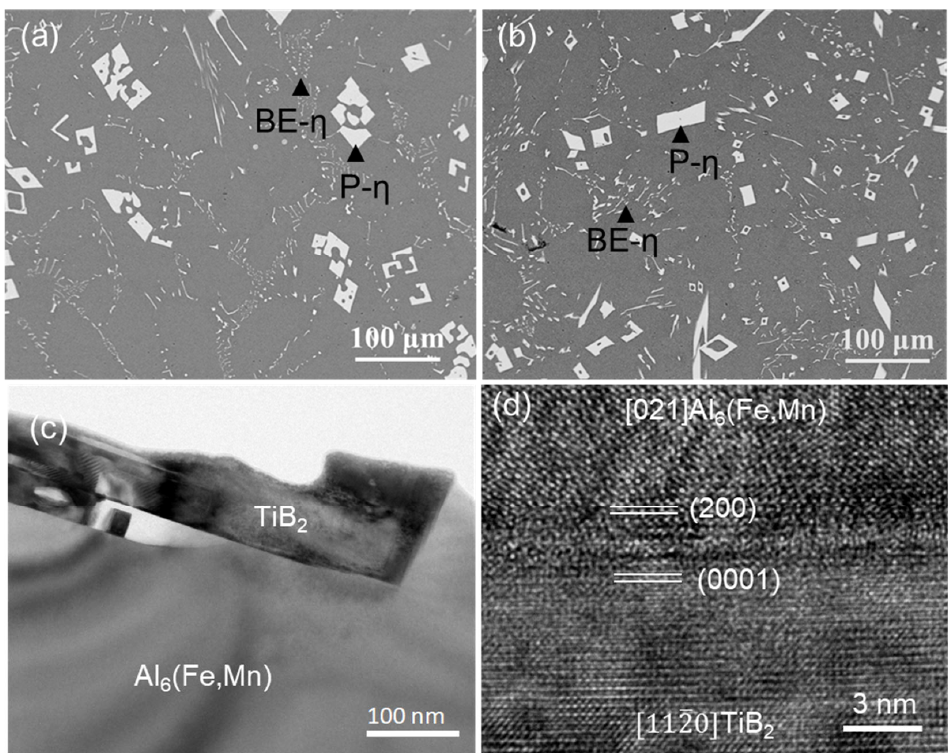
Figure 20. Mn ‐ modified TiB 2 particles nucleate η‐ Al 6 (Fe, Mn) phase and refine η‐ Al 6 (Fe, Mn) phase in Al ‐ 2Mn ‐ 1.0Fe alloy. SEM images showing the microstructure of Al ‐ 2Mn ‐ 1.0Fe alloy solidified at 3.5 K/s ( a ) without grain refiner addition, ( b ) with 1000 ppm novel grain refiner addition (Mn ‐ modified TiB 2 particles); ( c ) TEM bright ‐ field image showing the TiB 2 / η‐ Al 6 (Fe, Mn) interface, ( d ) high ‐ resolution TEM image showing the modified TiB 2 / η‐ Al 6 (Fe, Mn) interface. [82]. The grain refinement results are summarised in Table 5. The interfacial segregation of different elements, such as Fe, Mn, and Si, on AlB 2 or TiB 2 particles [82] were investi ‐ gated and confirmed on an aberration (Cs) ‐ corrected FEI Titan 80–200 instrument equipped with Super ‐ X energy ‐ dispersive X ‐ ray spectroscopy (Super ‐ X EDS) system. These different types of Al ‐ Ti ‐ B master alloys containing modified AlB 2 or TiB 2 particles were added to different alloys shown in Table 5 to test their effect on refining both FIMCs and α‐ Al. It shows that the TiB 2 particles with Fe and Si segregation (TiB 2 (Fe, Si)) are most effective. It can refine not only α and β FIMCs, but also the primary Si phase. TiB 2 (Fe, Si)) particles refined the α‐ Al 15 (Fe, Mn) 3 Si 2 from 38.7 ± 6.8 μ m to 11.1 ± 4.4 μ m in